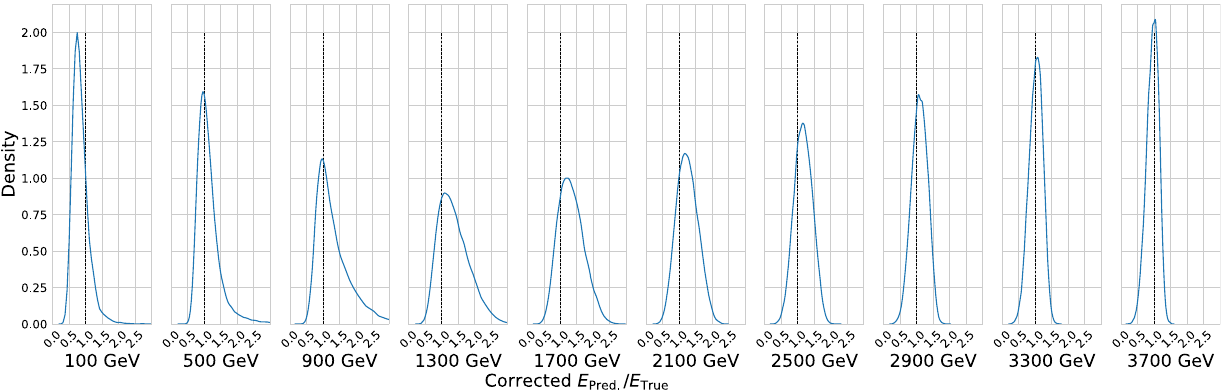
Fig. 11 Distributionsoftheratiosofcorrectedpredictionstotrueenergiesinbinsoftrueenergy.Theidealresponseherewouldbedeltadistributions centred at one. Distributions not centred at one are indicative of residual bias in the predictions for that energy range Fig. 12 Resolutions of the energy regression (Calorimeter), the simulated tracker, and their weighted average in a combined measurement. Resolution is computed on testing data at fixed points of true energy. The tracker is assumed to provide a linearly scaling resolution with a relative value of 20% at 1 TeV